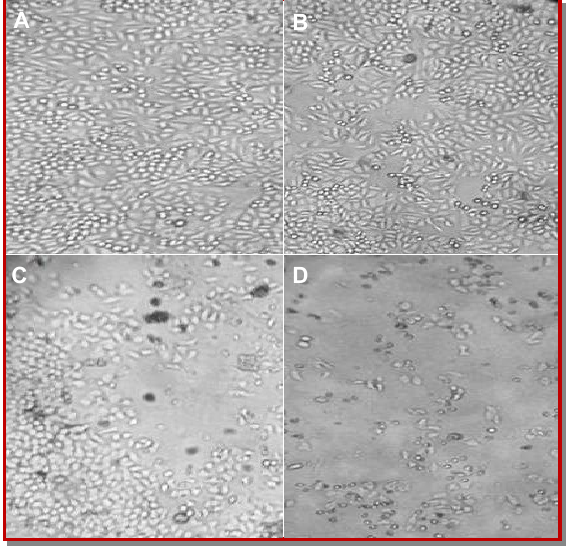
Figure 1: Human HeLa cervical carcinoma cell without treat- ment (A), at 75 μ g (B), at 100 μ g (C) of Clitoria ternatea extract and cisplatin-positive control